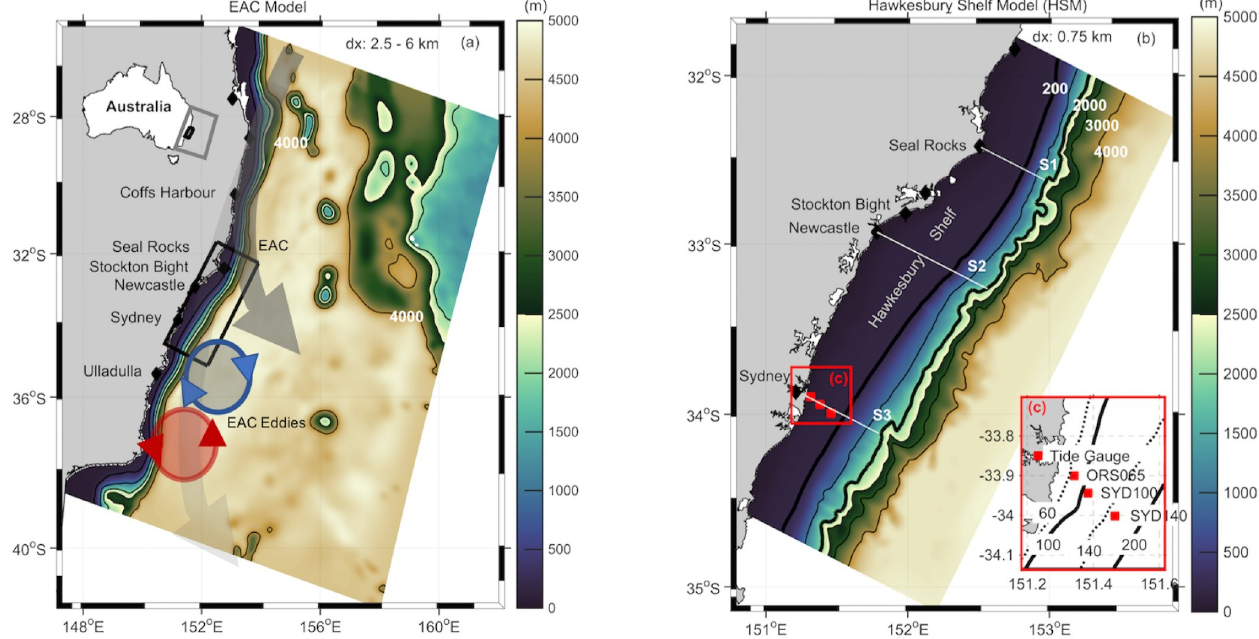
Fig 1. Spatial location, domains and bathymetry of the model grids. (a) East Australian Current (EAC) model domain with schematic of the main EAC flow overlaid, (b) Hawkesbury Shelf Model (HSM) domain. (c) The location of the observations used for model evaluation including the 3 moorings ORS065, SYD100 and SYD140, and the tide gauge station in Sydney Harbour indicated by the red squares. The 3 shore-normal sections from 0–2000 m used in the analysis are shown at Seal Rocks, Newcastle and Sydney, labelled as S1, S2 and S3 respectively. The horizontal cross-shelf resolution of each model is shown as dx. Colour shading in (a) and (b) represents the depth of the bathymetry (m).